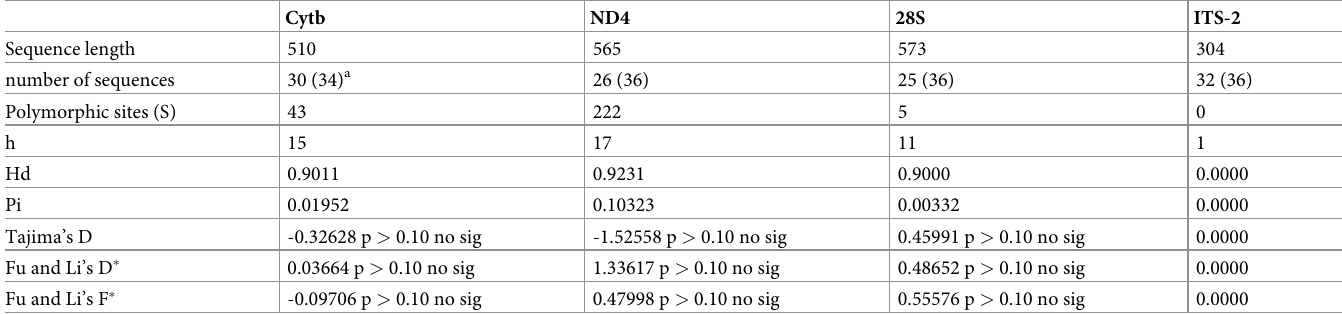
Table 1. Haplotype and polymorphism data analysis summary for Boyaca´